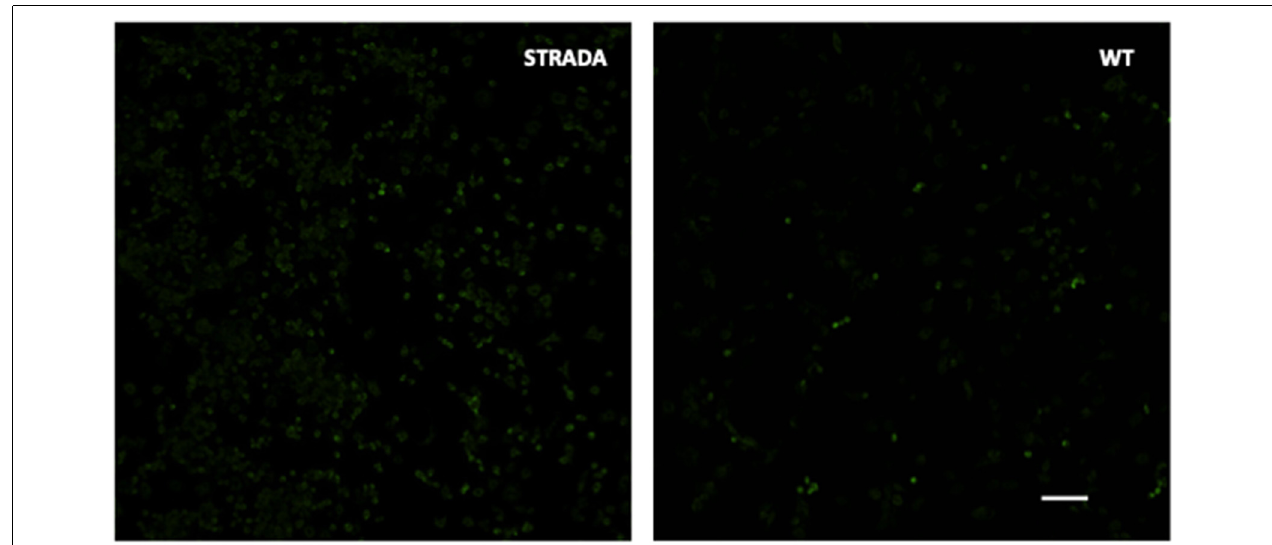
FIGURE 1 | Immunocytochemistry showing enhanced phosphorylation of ribosomal S6 protein in CRISPR-edited Strada N2a cells vs. wildtype (WT) cells. Scale bar, 250 microns.